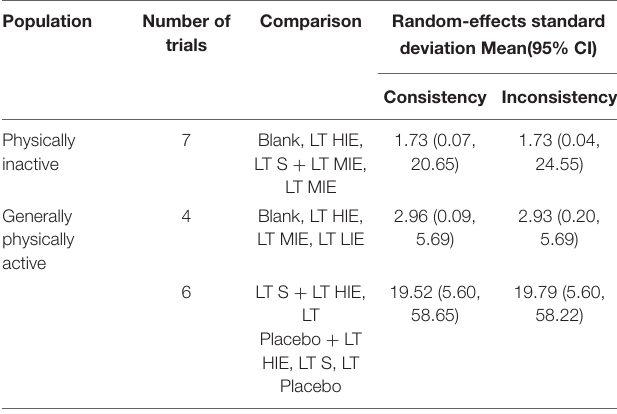
TABLE 3 | The random-effects standard deviation of mixed interventions comparisons under consistency and inconsistency models. Population